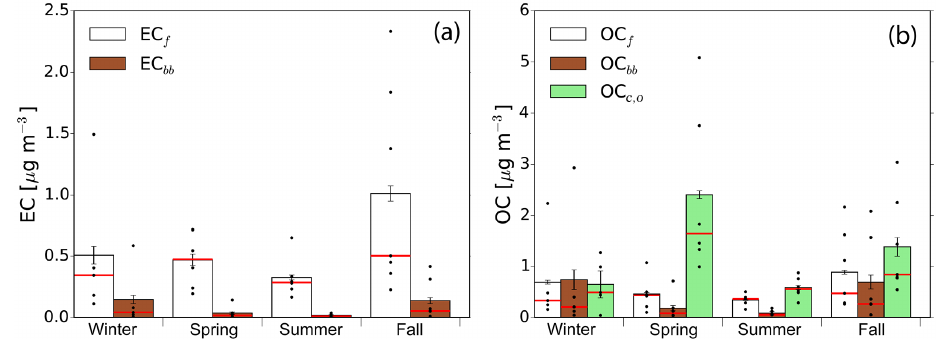
Figure 5. Concentrations of different subfractions of OC and EC from various sources averaged for winter, spring, summer, and fall in 2011/12. The bars show the average concentrations and the error bars the propagated uncertainties from the Monte Carlo simulations. The red line shows the median concentration. The individual data points are shown as black dots. (a) EC from fossil-dominated sources (EC f ) and from biomass combustion (EC bb ) ; (b) OC from fossil-dominated sources (OC f ) , biomass combustion (OC bb ) , and biogenic sources (OC c , o )